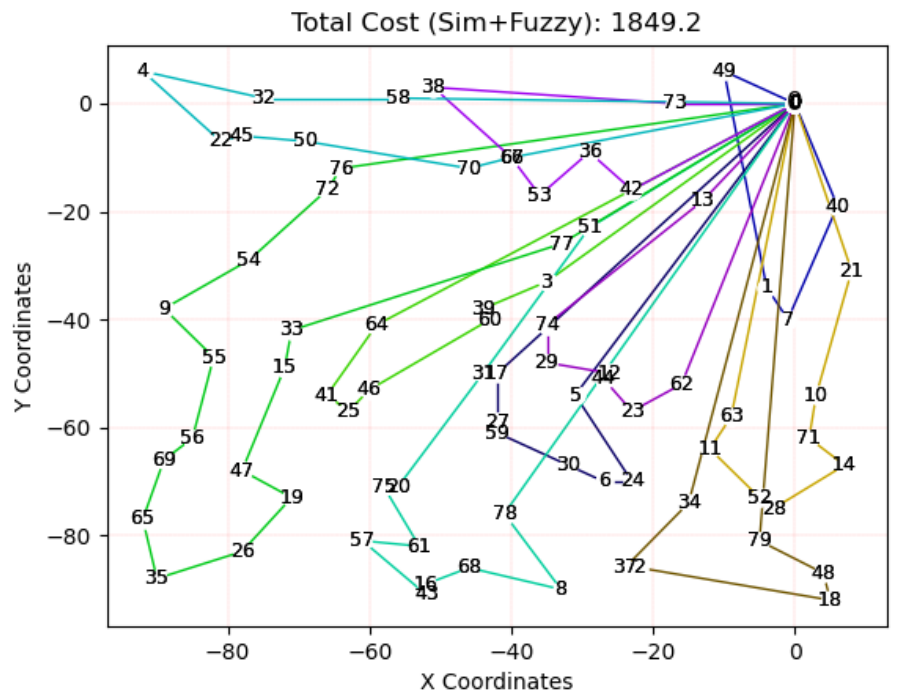
Figure 12. Best solution for VRP-Stochastic and Fuzzy scenario.